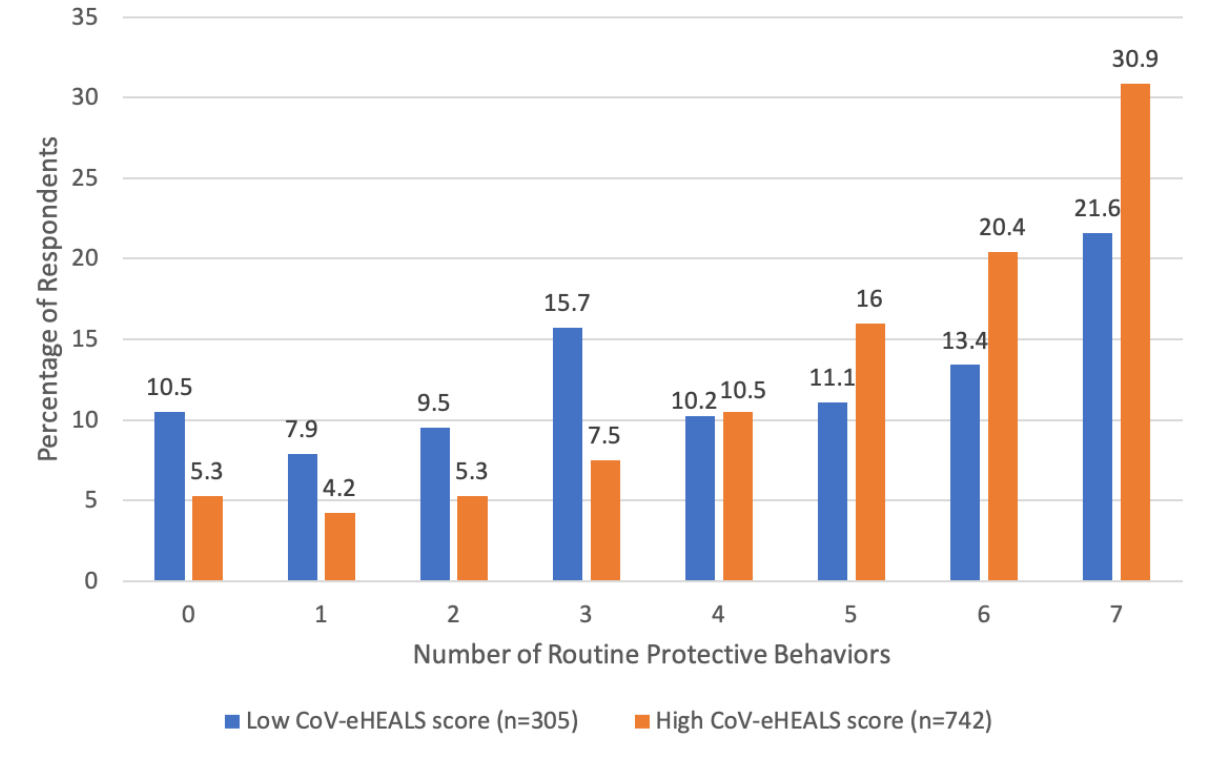
Figure 3. Number of routine protective behaviors by coronavirus-related eHealth